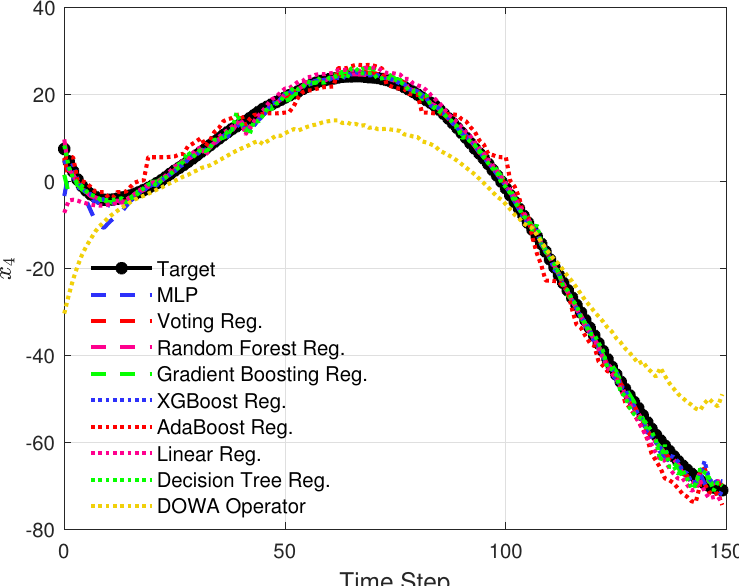
Figure 16. Fusion results for one Monte Carlo simulation for state 4.